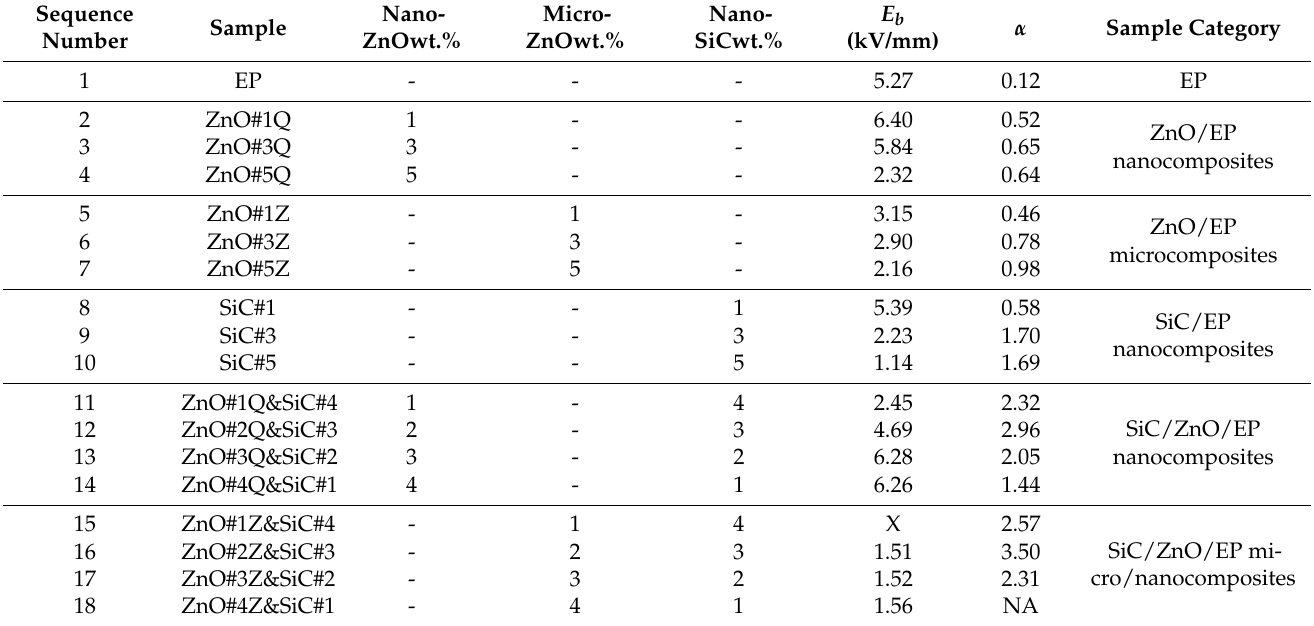
Table 10. Composition, nomenclature, and nonlinear coefficient of epoxy-based composites with different fillers [95]. Sequence Number